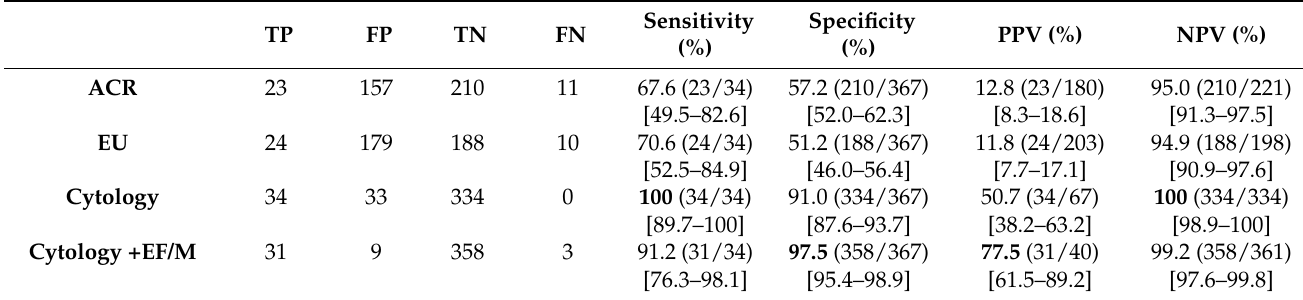
Table 4. Diagnostic performances of TIRADS systems, cytology, and combination of US features and cytology in the diagnosis of malignant nodules ( n =